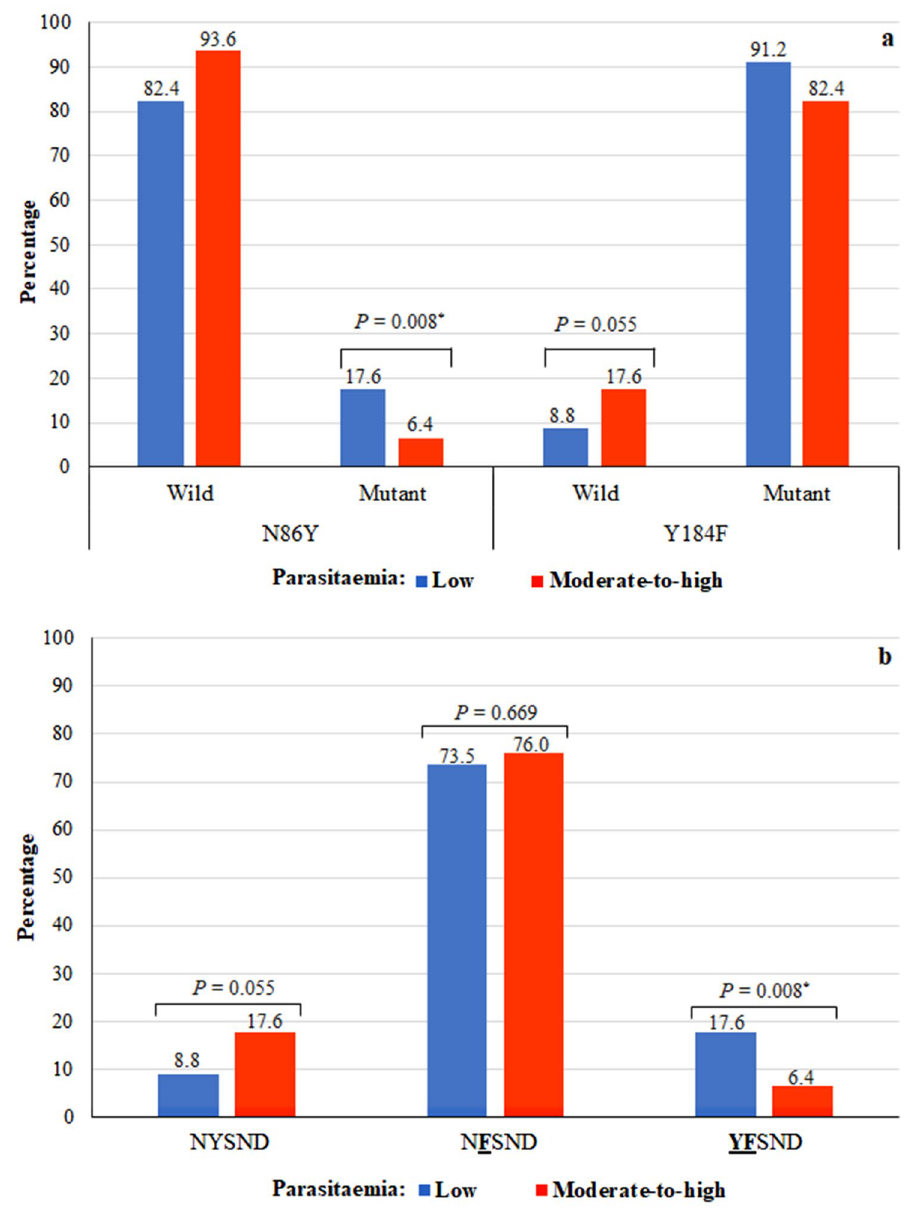
Figure 3. Association of pfmdr1 N86Y and Y184F mutations and haplotypes with parasitaemia in isolates from Jazan region. Parasitaemia levels: low (< 1000 parasites/μl of blood); moderate-to-high (≥ 1000 parasites/μl of blood). Mutant alleles are bold and underlined. *Significant association ( P < 0.05). ( a ) pfmdr1 N86Y and Y184F mutations. ( b ) pfmdr1